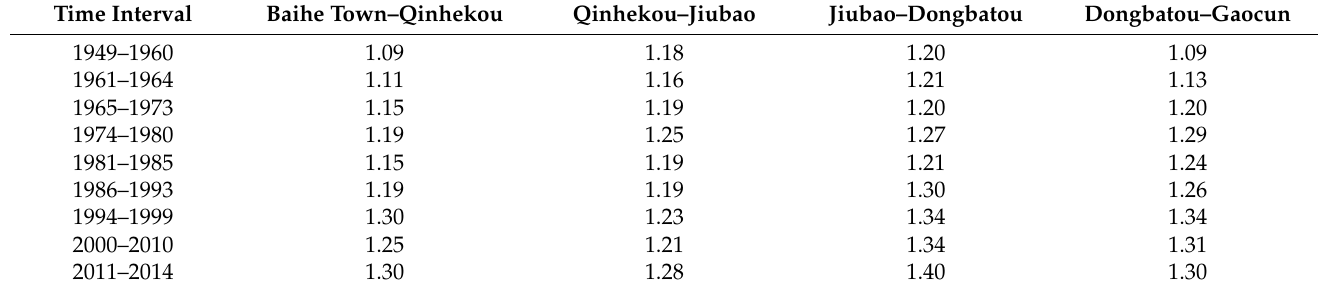
Table 7. Bending coefficient of main streamline in the wandering reach from 1949 to 2014.